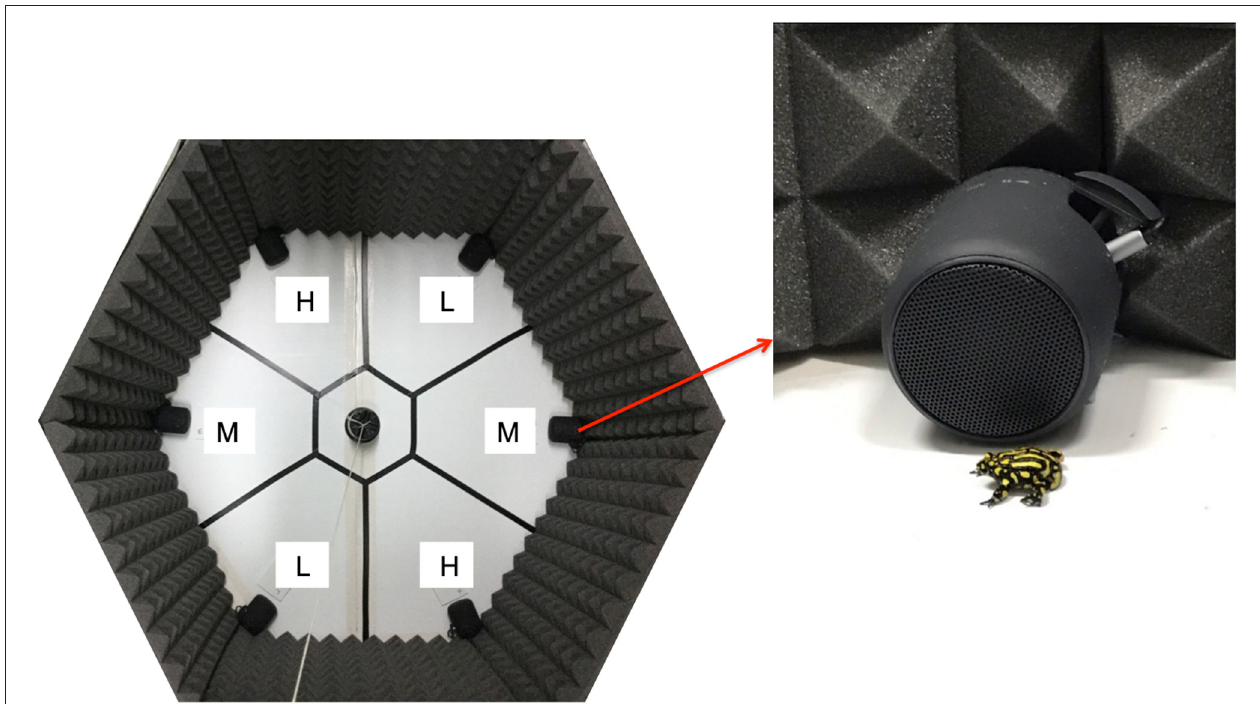
FIGURE 1 | Hexagonal six-choice phonotaxis arena used to test female preferences for male call frequency in P. corroboree . The arena was divided into six call zones—L, low frequency call zone; M, medium (average) frequency call zone; H, high frequency call zone. There was also a central “no choice” zone from which each test subject was